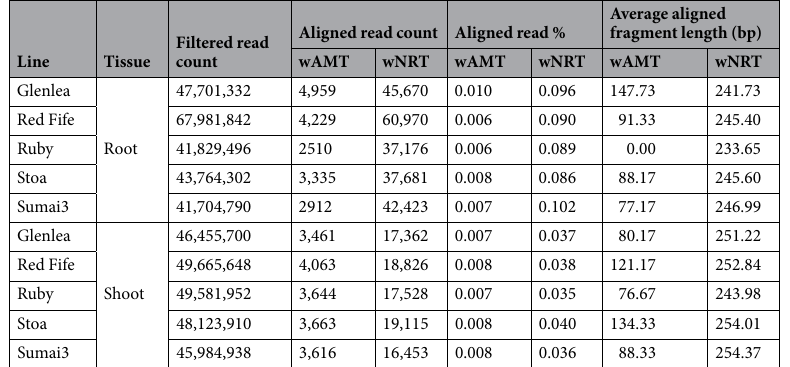
Table 1. Read alignment summary of root and shoot transcriptome of five lines to wheat ammonium transporter (wAMT) and wheat nitrate transporters (wNRT)